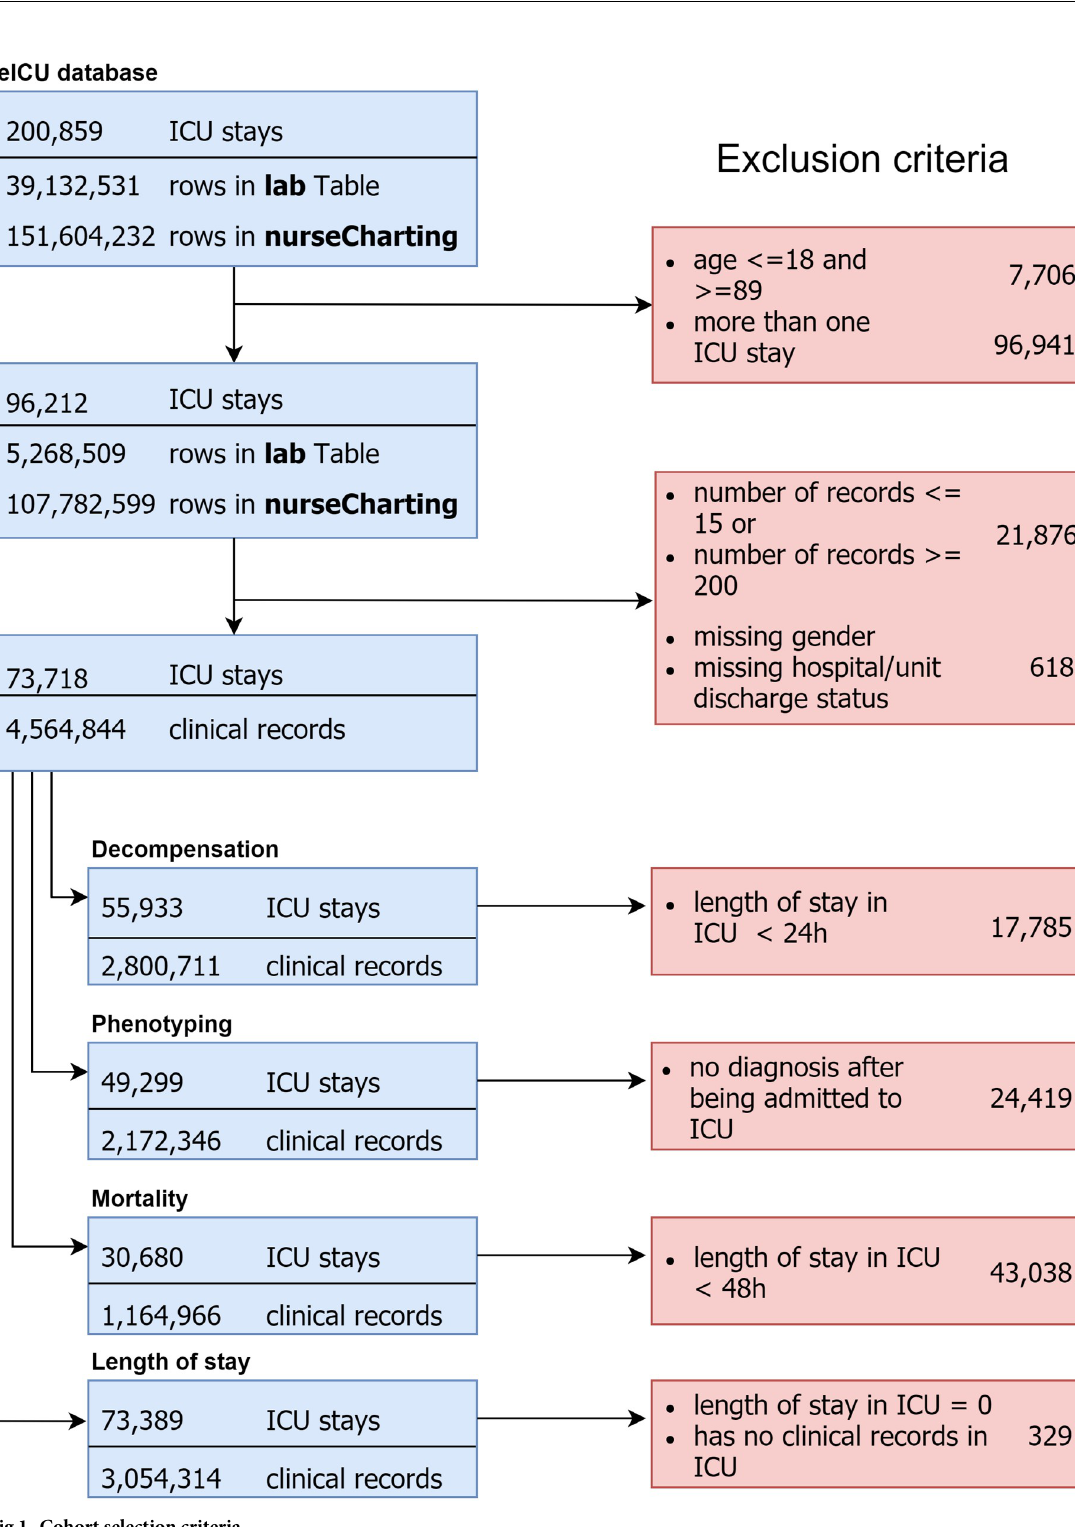
PLOS ONE | https://doi.org/10.1371/journal.pone.0235424 July 2,